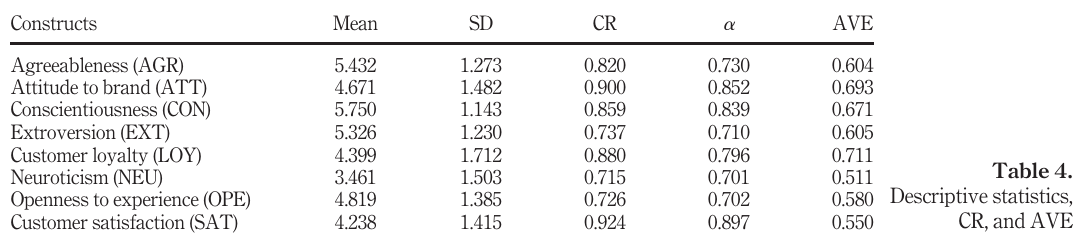
Table 3. Item loading for resulting outer